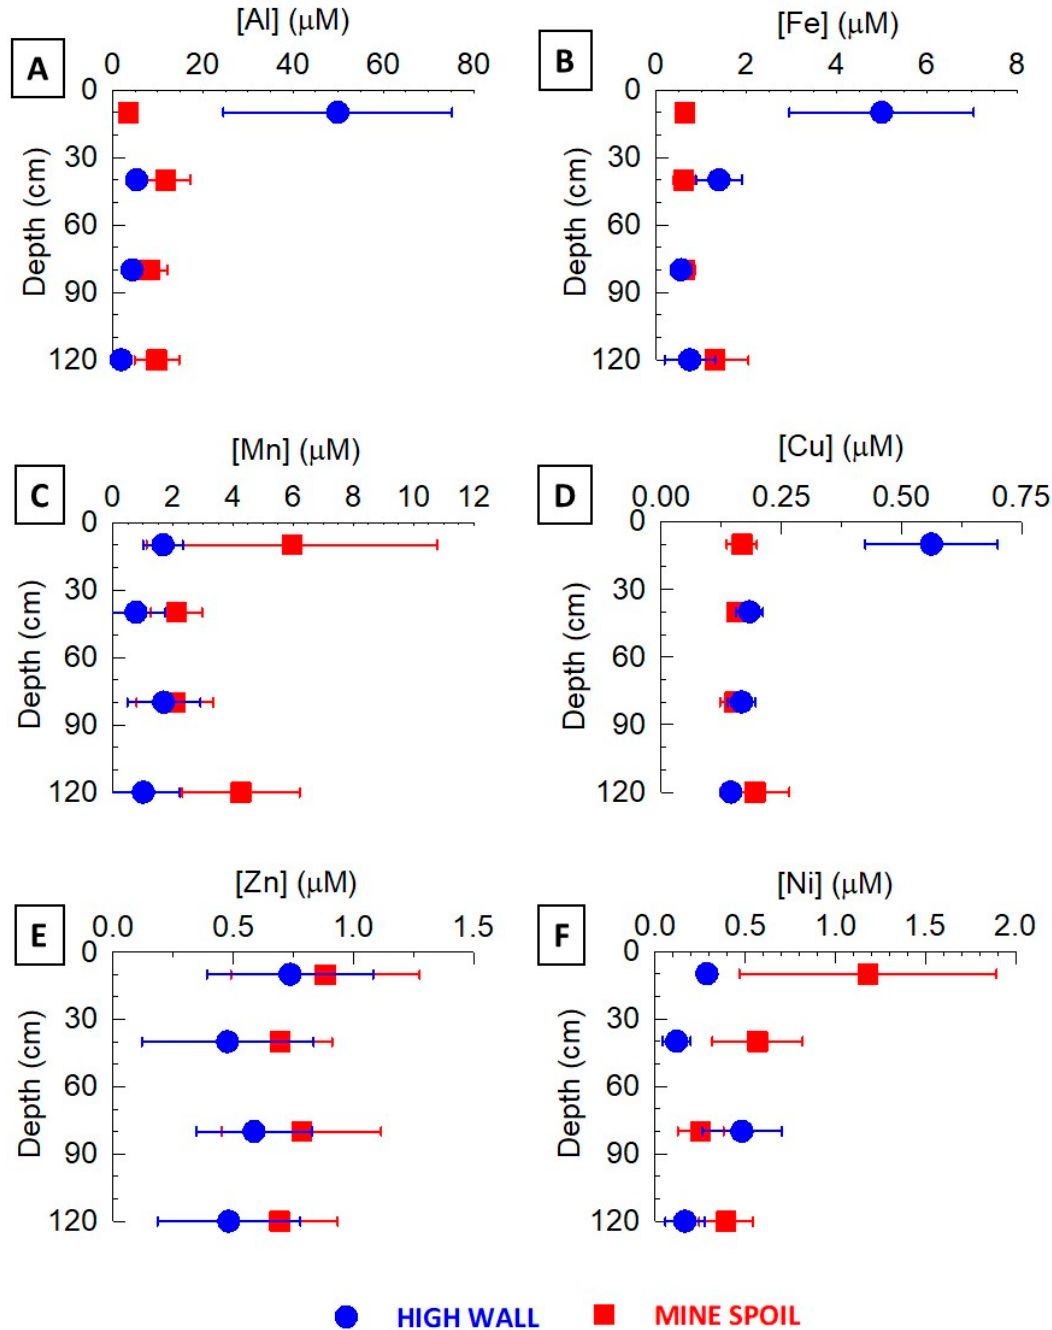
Figure 6. Average concentrations for Al ( A ), Fe ( B ), Mn ( C ), Cu ( D ), Zn ( E ), and Ni ( F ) collected from lysimeters installed in high wall soils (blue circles, left) and mine spoil soils (red squares, center) over the sampling season for lysimeters installed at 10, 40, 80, and 120 cm. Errors represent one standard deviation of the averaged values over the sampling period.